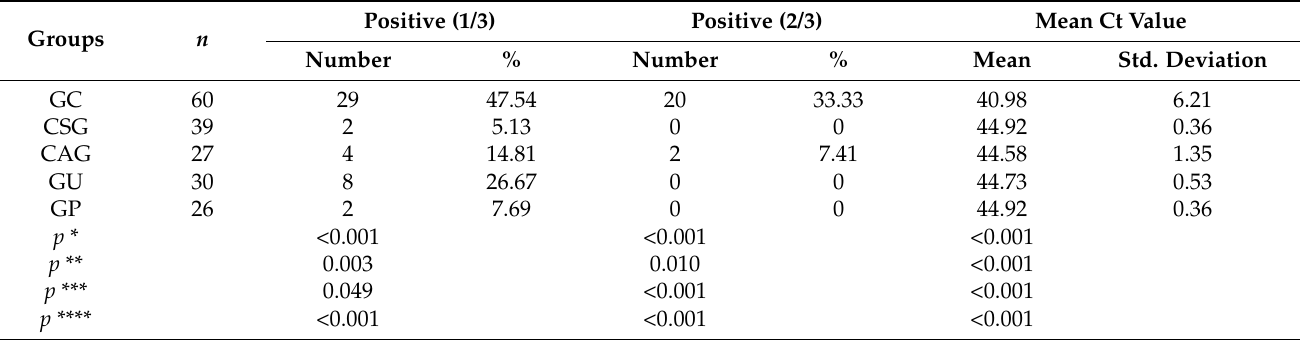
Table 1. The mean Ct value and positive rate of mSEPT9 in each enrolled